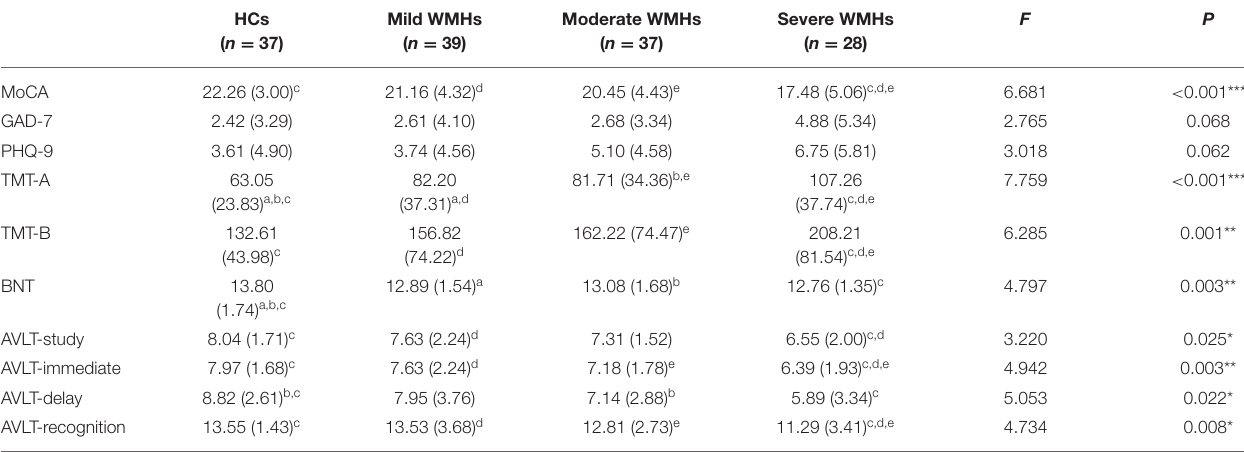
TABLE 3 | Neuropsychological tests of participants in the four groups [Mean